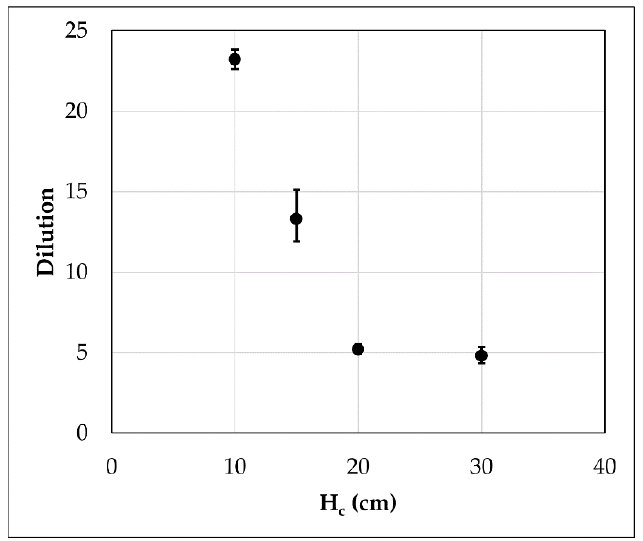
Figure 5. Dilution measurements for confined plunging jet experiments with H–H c = 20 cm, L j = 60 cm, D c = 4.4 cm and ∆s = 10 psu.